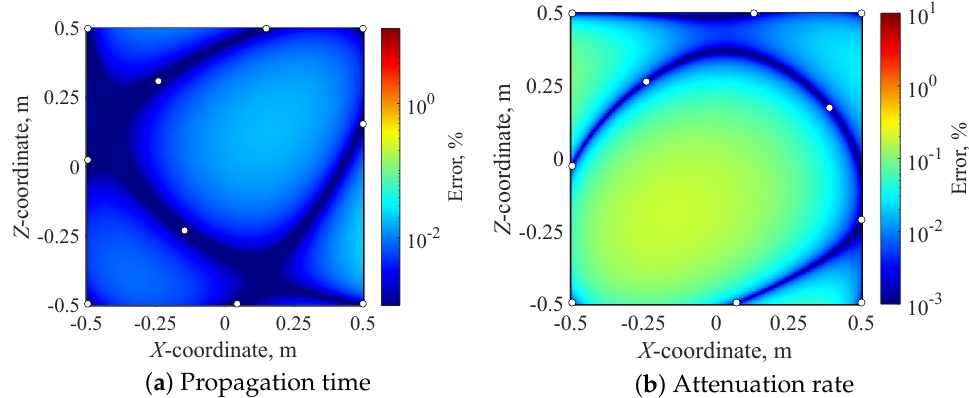
Figure 9. Distributions of error in the sound source grid estimated by sparse sampling( p = r , 10 sampling